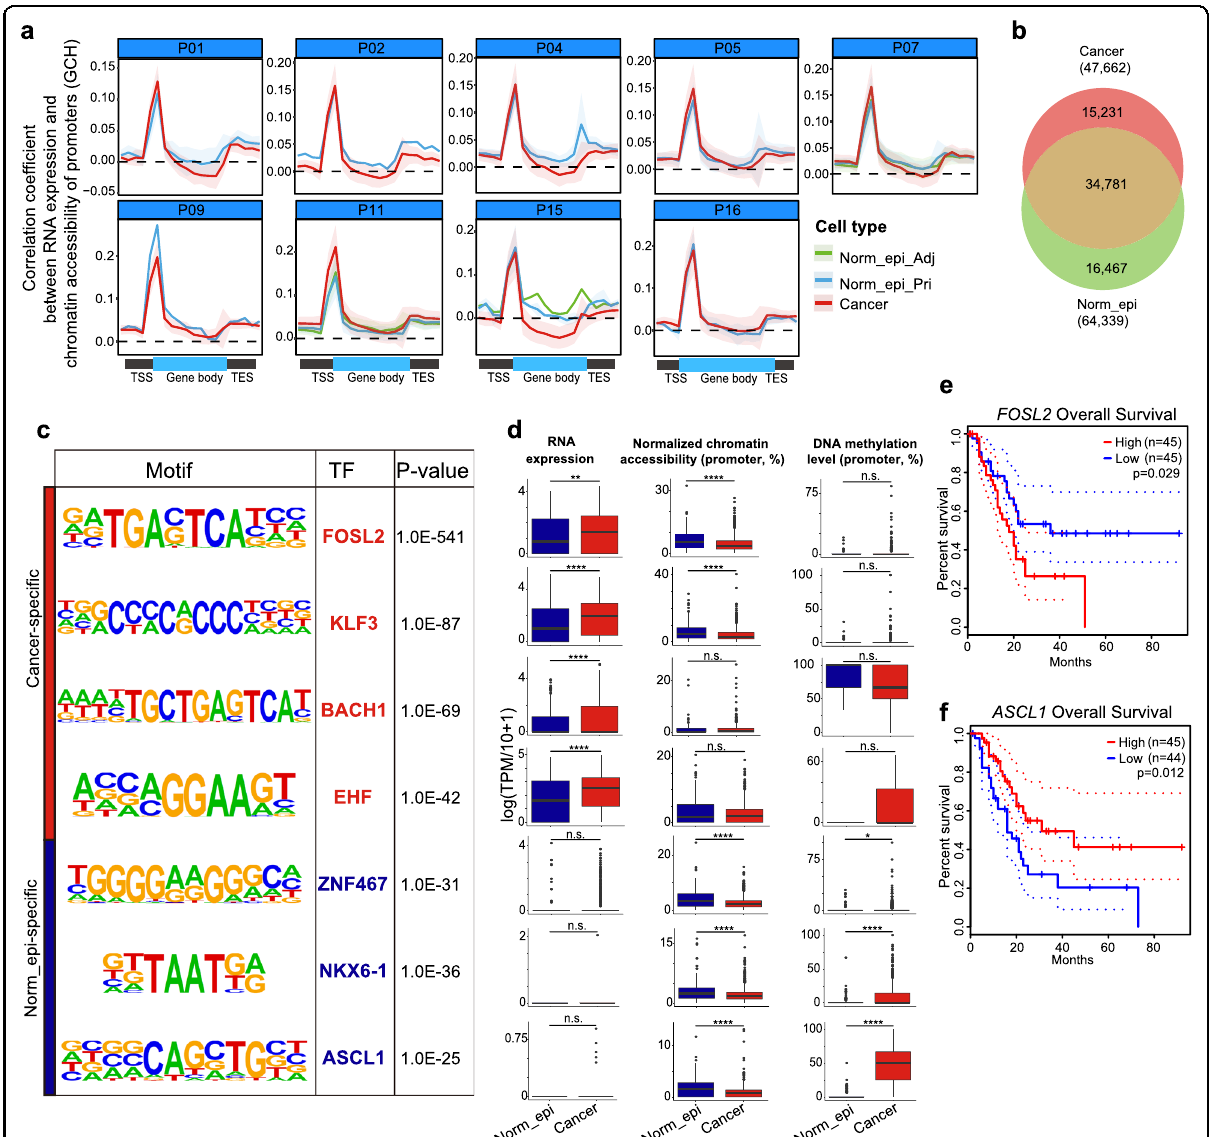
Fig. 5 NDRs and TF motif enrichment in PDAC. a Spearman correlations between chromatin accessibility across gene bodies (including 15kb fl anking regions) and corresponding RNA expression levels in each cell type. b Venn diagram indicating the NDR numbers in cancer cells and Norm_epi cells. NDRs in two types of cells are de fi ned as a shared NDR when they have at least a 100-bp overlap. Merged NDRs in two types of cells were de fi ned with two standards: (1) NDRs were merged when they had at least a 100-bp overlap; (2) each merged NDR was detected in at least 11 cells in Norm_epi cell group and 53 cells in the cancer cell group. c Representative cancer-speci fi c and Norm_epi-speci fi c motifs and corresponding candidate TFs. d RNA expression levels, chromatin accessibility, and DNA methylation levels in the promoter regions of each candidate TF. The statistical test was carried out using the Wilcoxon rank-sum test. n.s., no signi fi cance; * P < 0.05; ** P < 0.01; *** P < 0.001; **** P < 0.0001. e , f Overall survival of PDAC patients grouped by two representative genes. The survival data were obtained from the TCGA